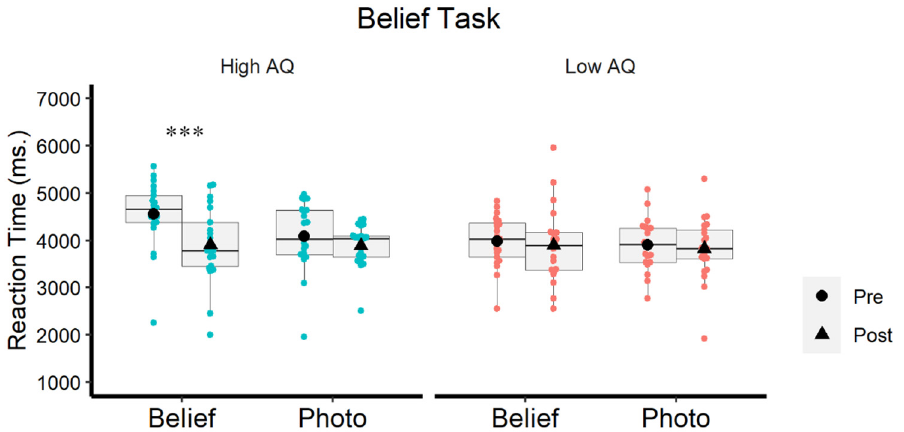
Figure 4. Reaction times in the belief tasks in the high-AQ group ( left ) and the low-AQ group ( right ) as a function of Modality (false belief and false photo) and Test (pre- and post-test). Only significant effects of test are signaled (*** p < 0.0001).